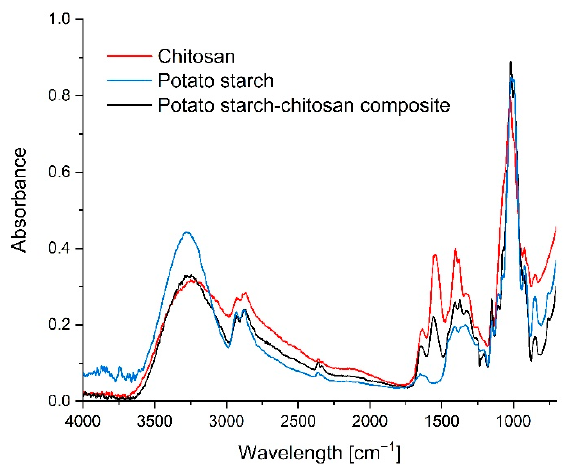
Figure 3. FTIR spectra of chitosan, potato starch, and the starch–chitosan composite.